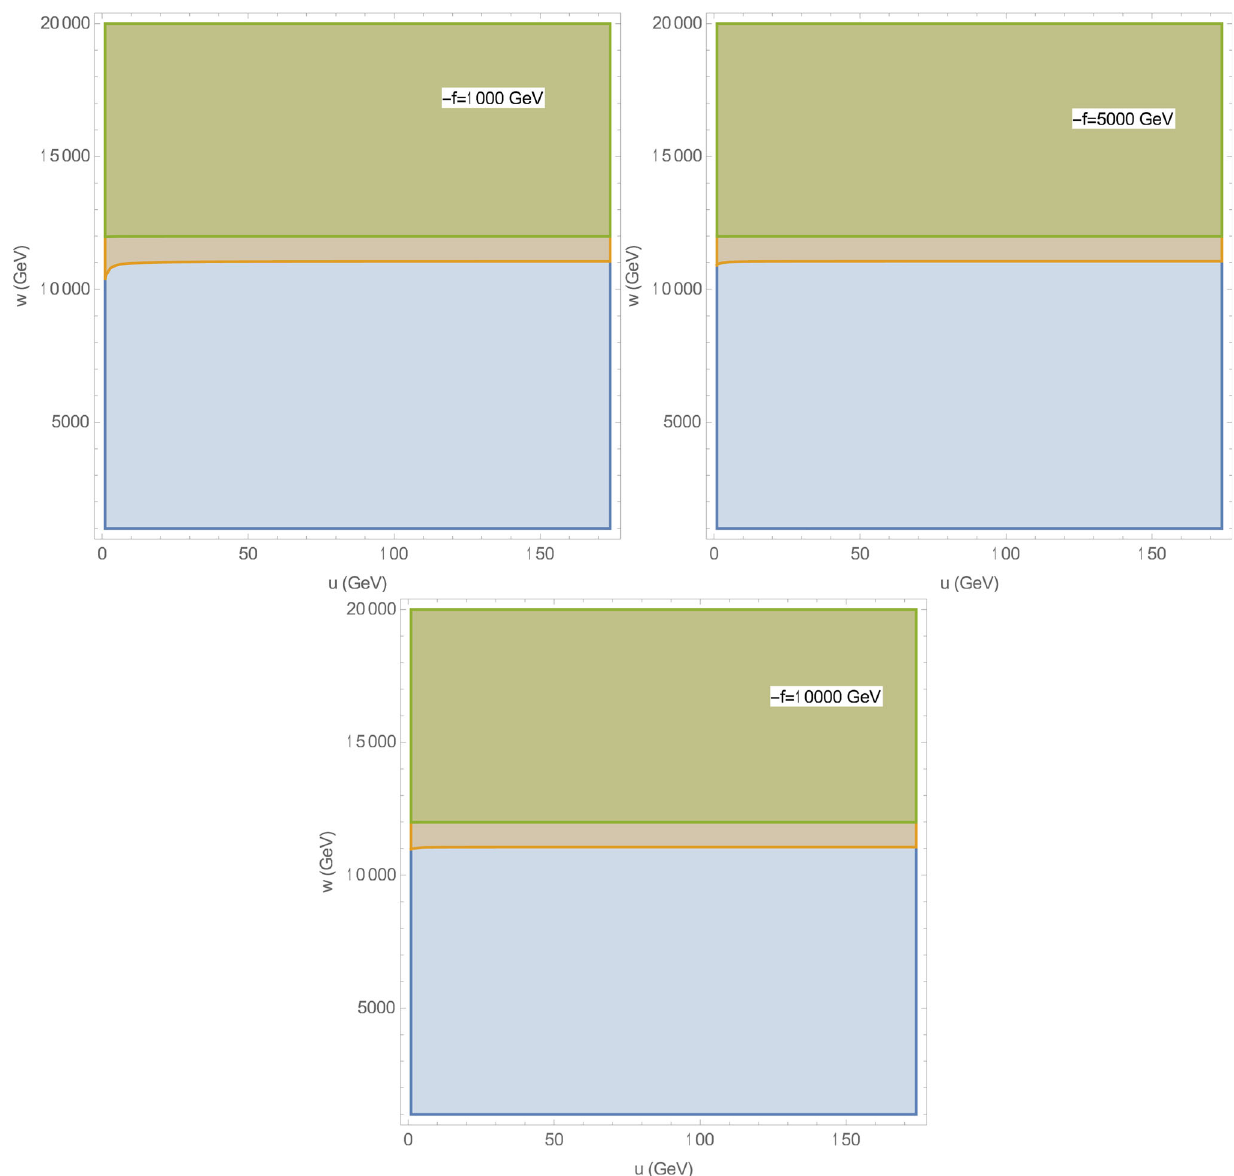
Fig. 1 Constraints for w and u from the meson mass differences (cid:3) m K , (cid:3) m B whereas the orange and green regions are for (cid:3) m B